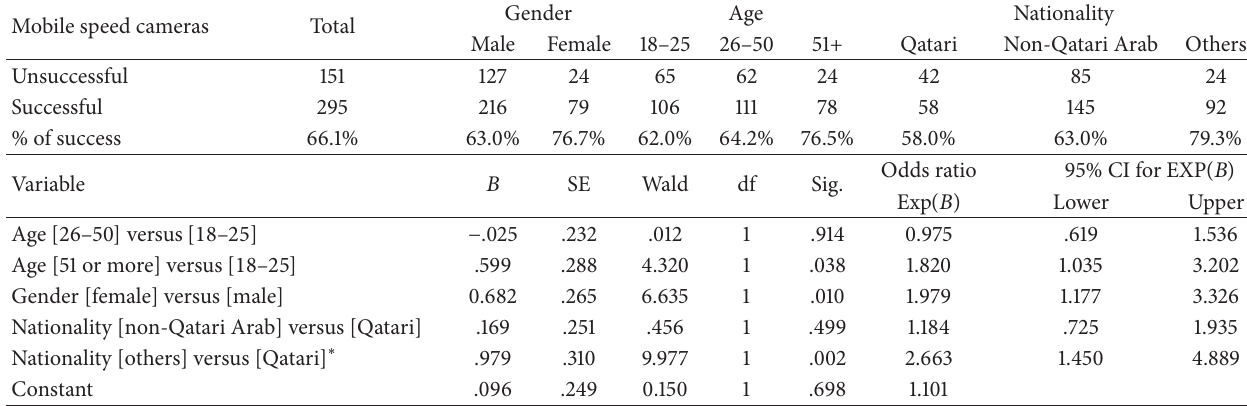
Table 6: Reported success and logistic model results for the mobile speed cameras strategy.